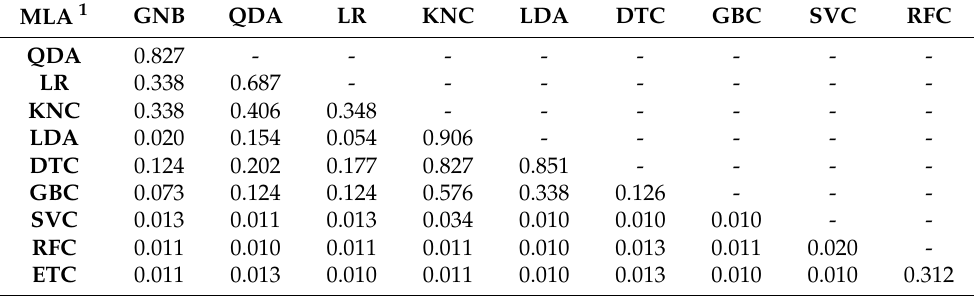
Figure 4. Preview of the bark beetle spots generated by the top ETC-based model. Green color represents unaffected spruce forest; blue color represents bark beetle infestation spots generated by the top ETC-based model; red color represents damaged forest identified on LANDSAT images. The MLA codes are given in Table 3, and the variables of the top models are listed in Table 4. Table 5. p -values of the pairwise permutation t -test of φ of the top